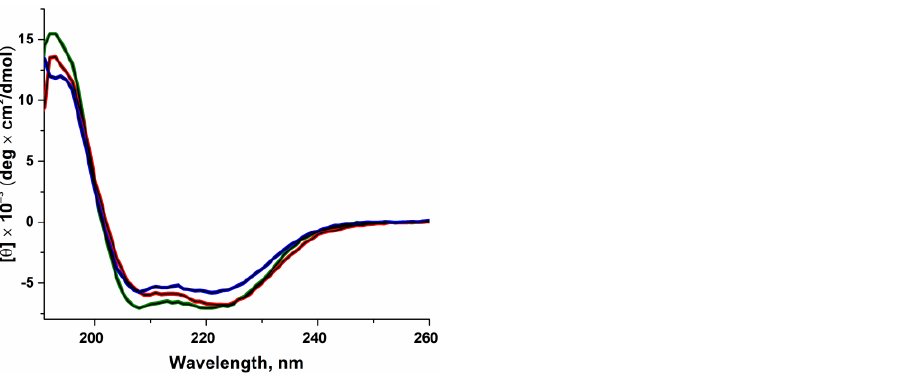
Figure 2. CD spectra of WT Polβ (green) and of variants G118V (red) and R149I (blue). The simulation results are the black curve. Table 1. Percentages of α-helices in the studied proteins.